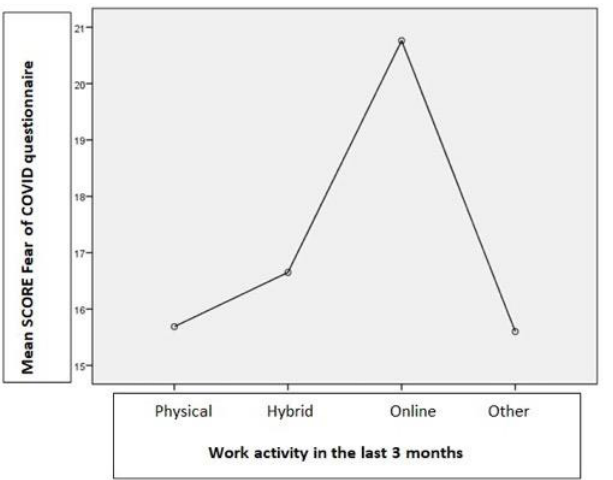
Figure 1. Mean score of the participants to the Fear of COVID questionnaire based on their work activity.